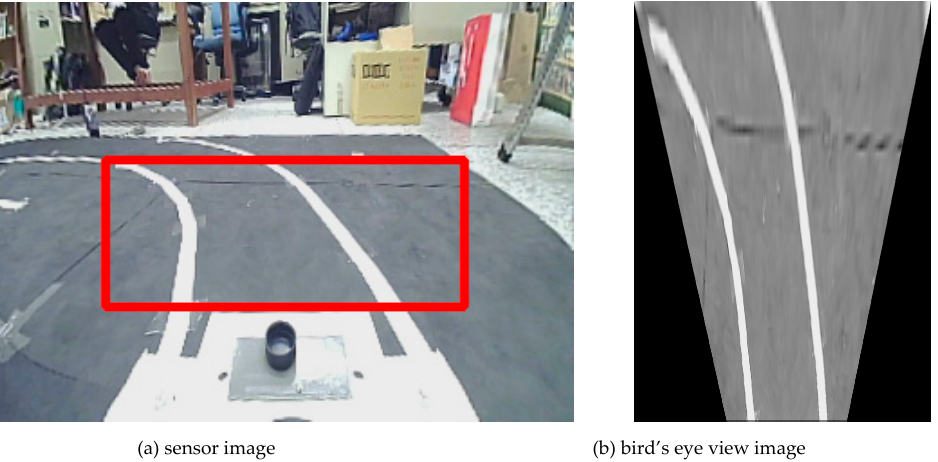
where k is a constant to preserve lane markings, 𝑀(𝐼) is the peak with the highest intensity value in histogram of the gray scale IPM image. The column intensity sum of the binary image can then be applied to locate the horizontal position 𝑥 𝐿 and 𝑥 (cid:3019) of the left and right lane marking and the lane width w , as shown in Figure 3b and 3c.